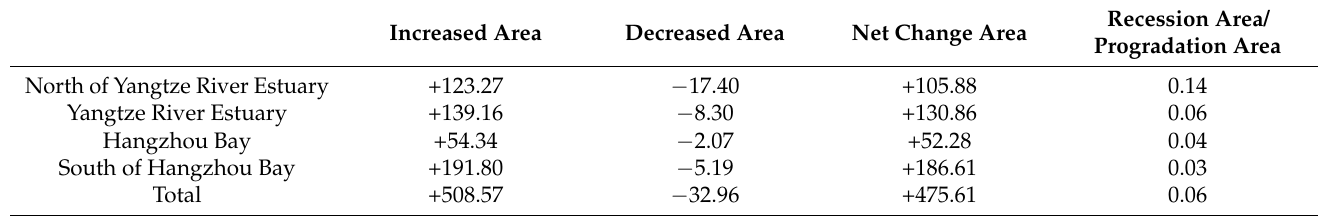
Figure 4. Pie chart of length of different coastline types in Yangtze River Delta and its four parts in 2013 and 2018 (Unit: km). Table 4. The progradation and recession area along coastlines for the four parts of the Yangtze River Delta within the five years (Unit: km 2